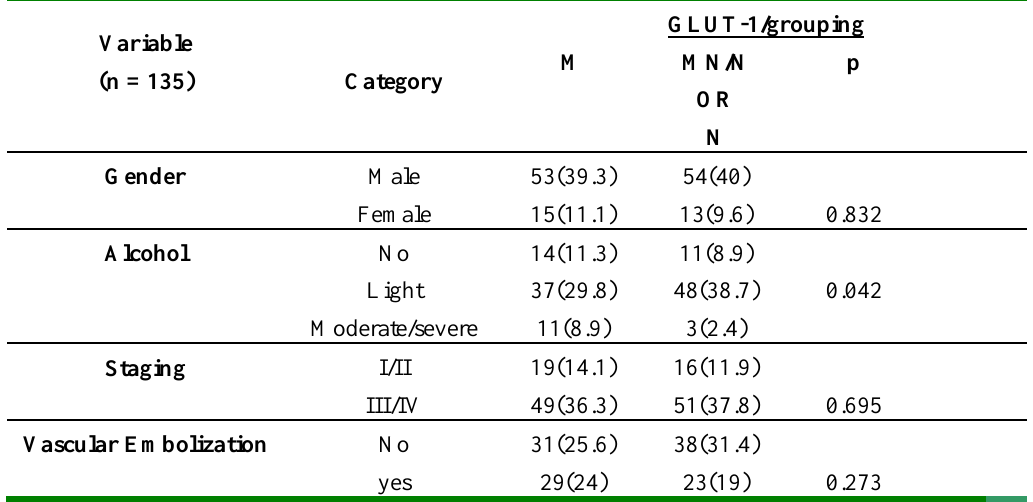
Table 2. Association between GLUT1 expression and clinic-pathological feature in OSCC.